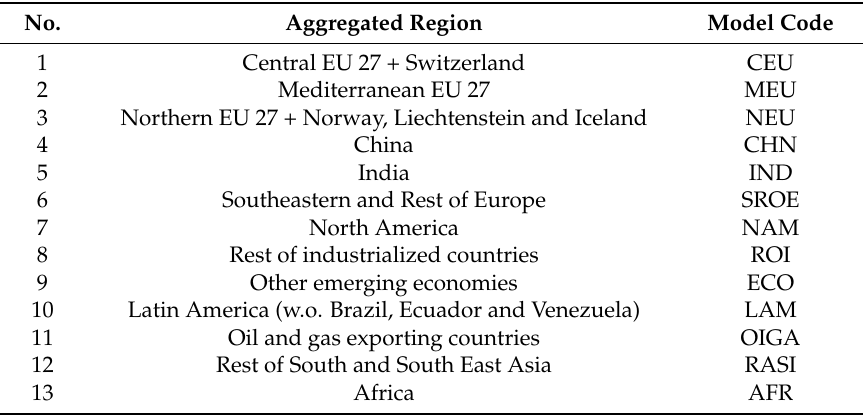
Table 1. Regional aggregation in the CGE model.